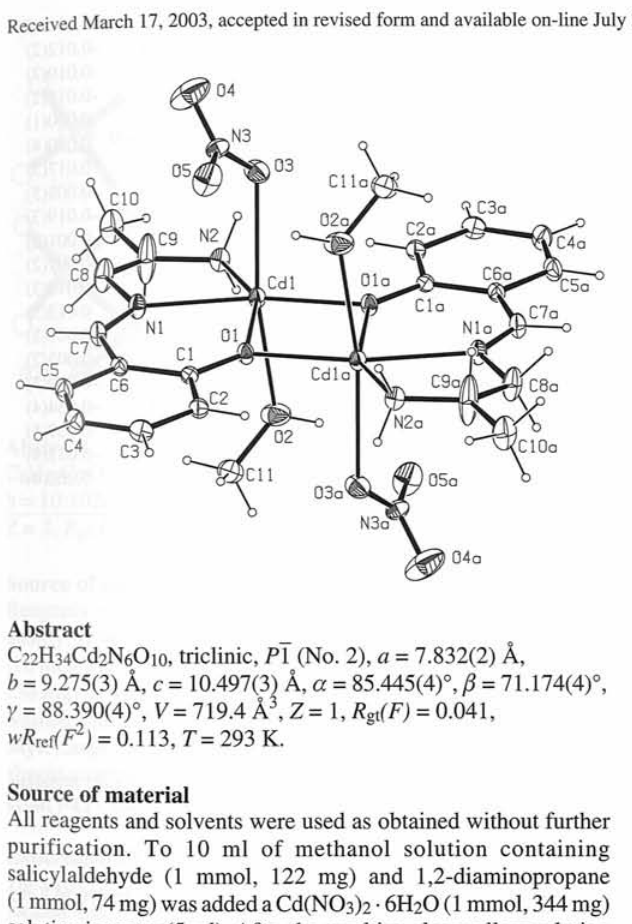
Table 1. Data collection and handling.